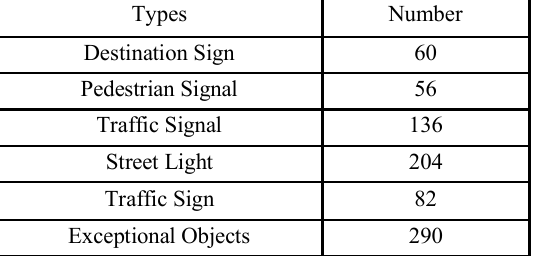
Table 2. Number of pole-like objects